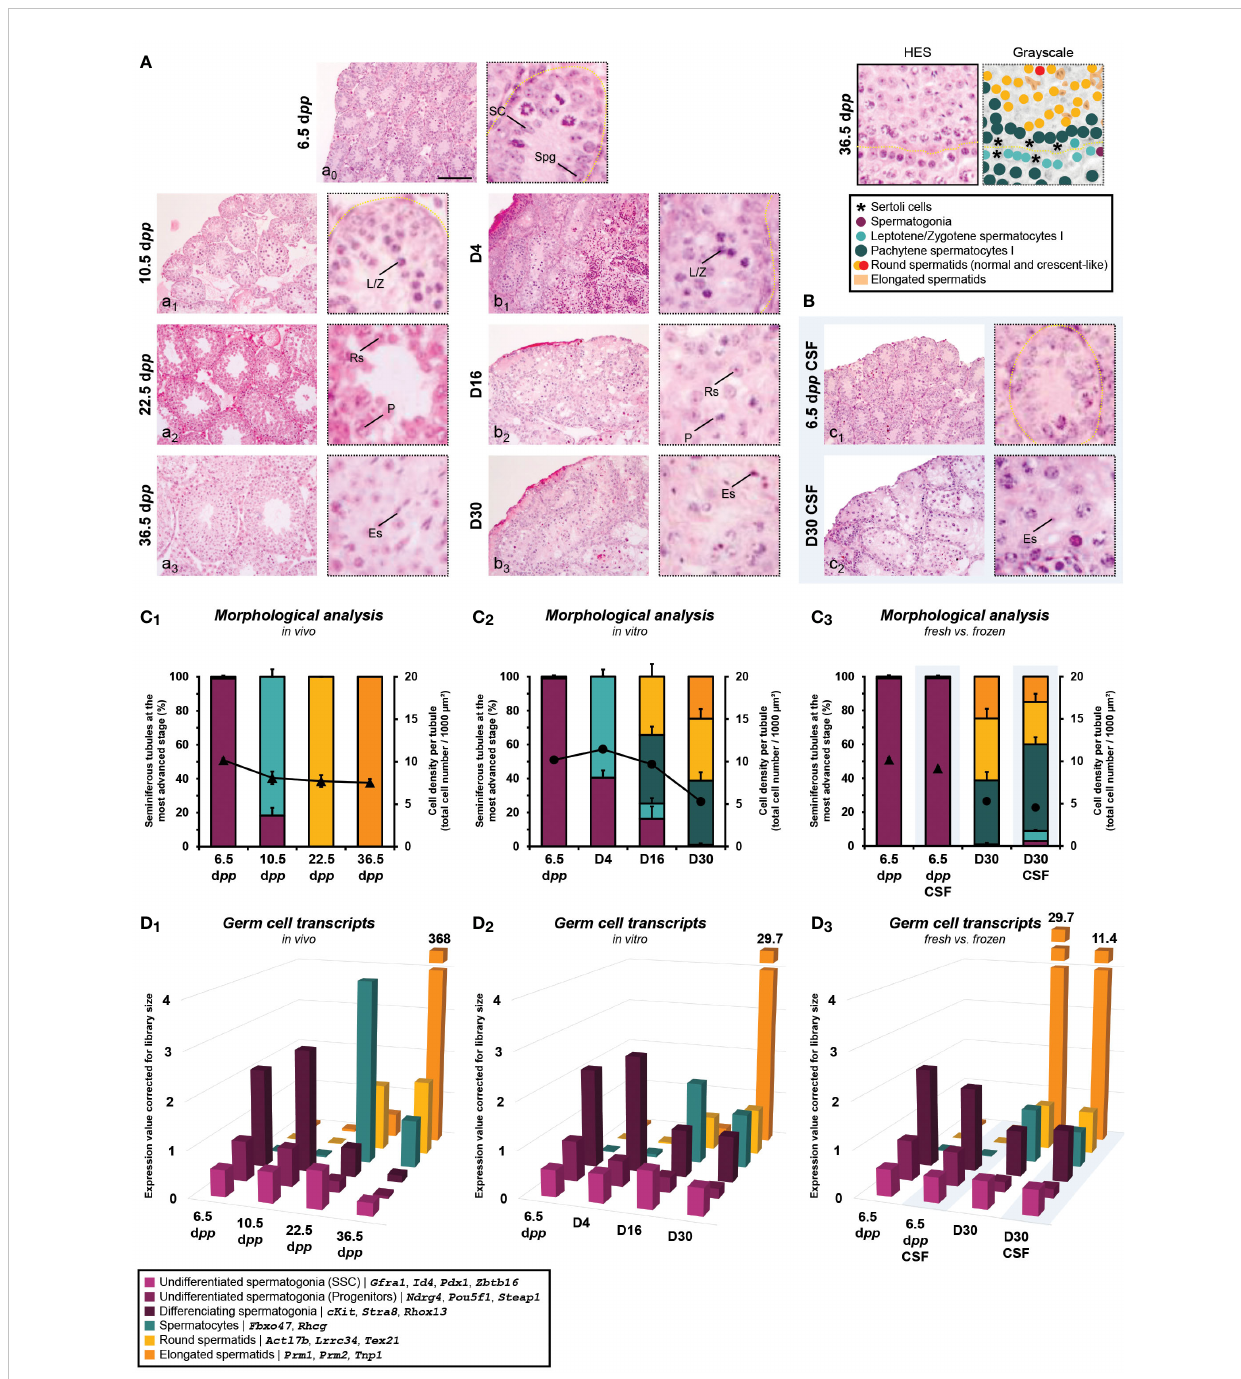
FIGURE 4 Testicular tissue assessment during the fi rst wave of spermatogenesis. Histological analysis performed in HES of postpartum in vivo testicular tissues (A, a 0 - 3 ) (n=3 testis ×3 slides ×30 seminiferous tubules) and testicular explants obtained throughout in vitro 30-day-organ culture of fresh (A, b 1 - 3 ) or frozen ( by CSF; B, c 1 - 2 ) tissues (n=3×6 fragments per condition ×3 slides ×30 seminiferous tubules). Magni fi cation ×200 (with additional ×5 numerical zoom for micrographs); scale bar: 100 m m. The percentage of seminiferous tubules containing differentiated germ cells at the most advanced stage and cell density per tubule ( ▲ , in vivo ; ● , in vitro ) were evaluated for in vivo (C 1 ) , in vitro (C 2 ) , and fresh vs . frozen (C 3 ) . Data are presented as mean ± s.e.m. RNA-Seq data of known genes corresponding to speci fi c germ cell stages were presented to have a relative comparison of different germ cell types between several conditions within in vivo testicular tissues (D 1 ) , in vitro explants (D 2 ) and fresh vs . frozen (D 3 ) . Data are presented as mean expression values corrected to library size. CSF, controlled slow freezing; d pp , days postpartum ; Es, elongated spermatid; HES, hemalun eosin saffron; L/Z, lepto-zygotene spermatocyte I; P, pachytene spermatocyte I; Rs, round spermatid; SC, Sertoli cell; Spg,